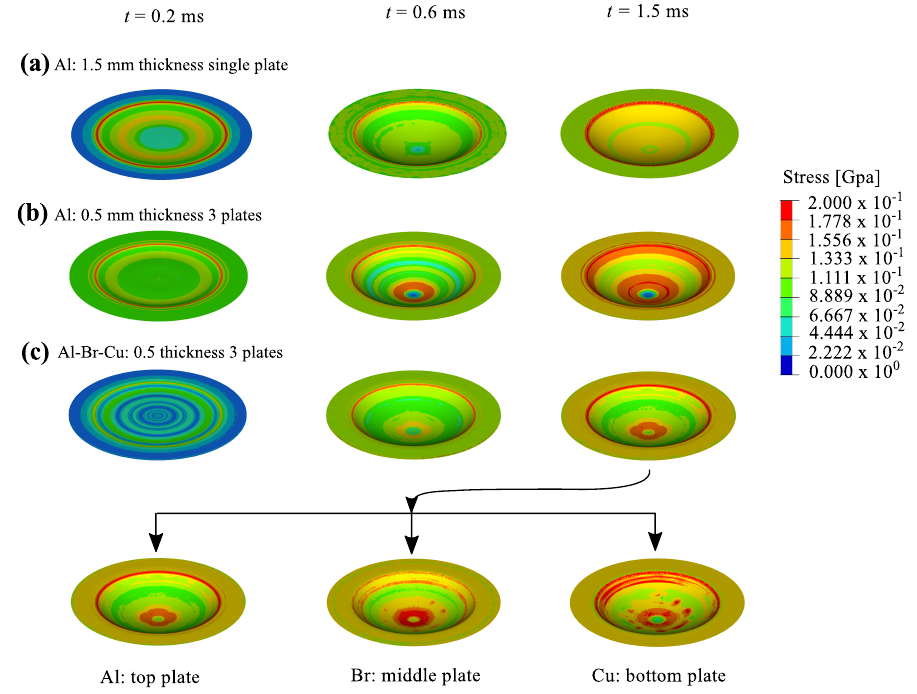
Figure 15. Comparison of von Mises stress distribution for a deformed metal using numerical simulations. ( a ) Al 1.5 mm thickness a single sheet, ( b ) Al 0.5 mm thickness stacked sheets and ( c ) Al-Br-Cu 0.5 mm thickness stacked